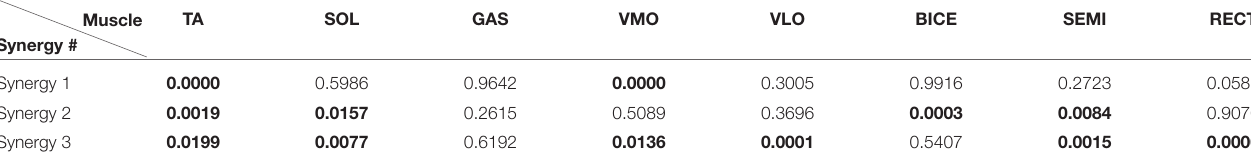
TABLE 1 | The p -values between muscle synergy W with ∈ R 3 × 8 and W without ∈ R 3 × 8 , p ≤ 0.05 indicates significant difference in statistics. Muscle Synergy #